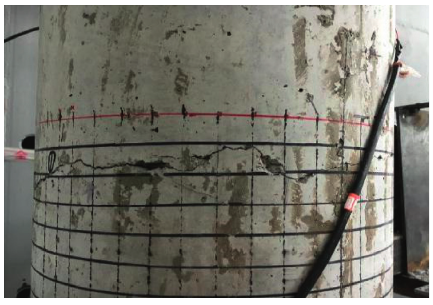
Figure 25: Back side damage condition of S